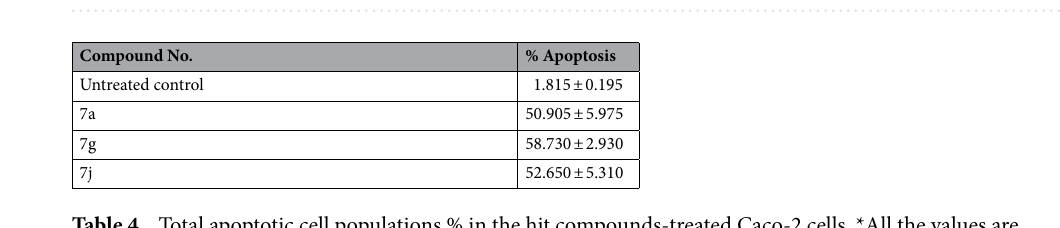
Table 4. Total apoptotic cell populations % in the hit compounds-treated Caco-2 cells. *All the values are demonstrated as mean ± SEM.